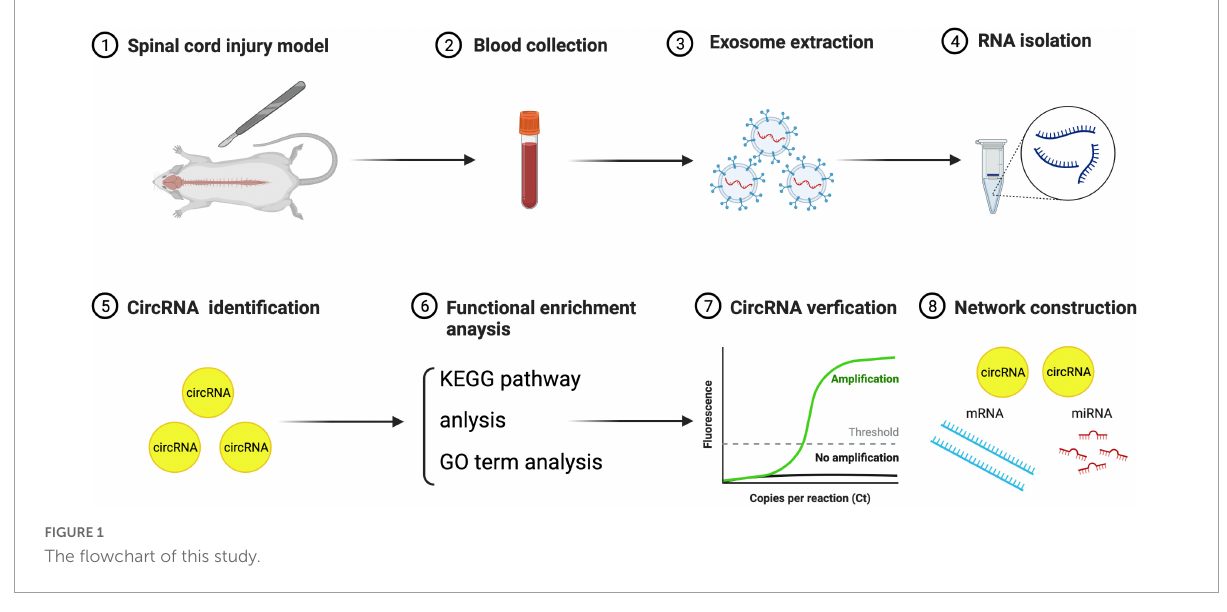
FIGURE1 The flowchart of this study.